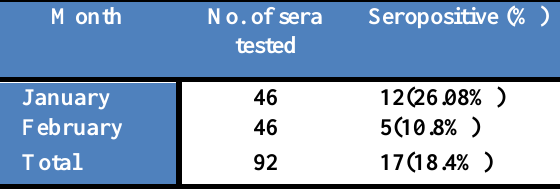
Table, 4: Distribution of T.gondii in horses by using ELISA according to according to the months.